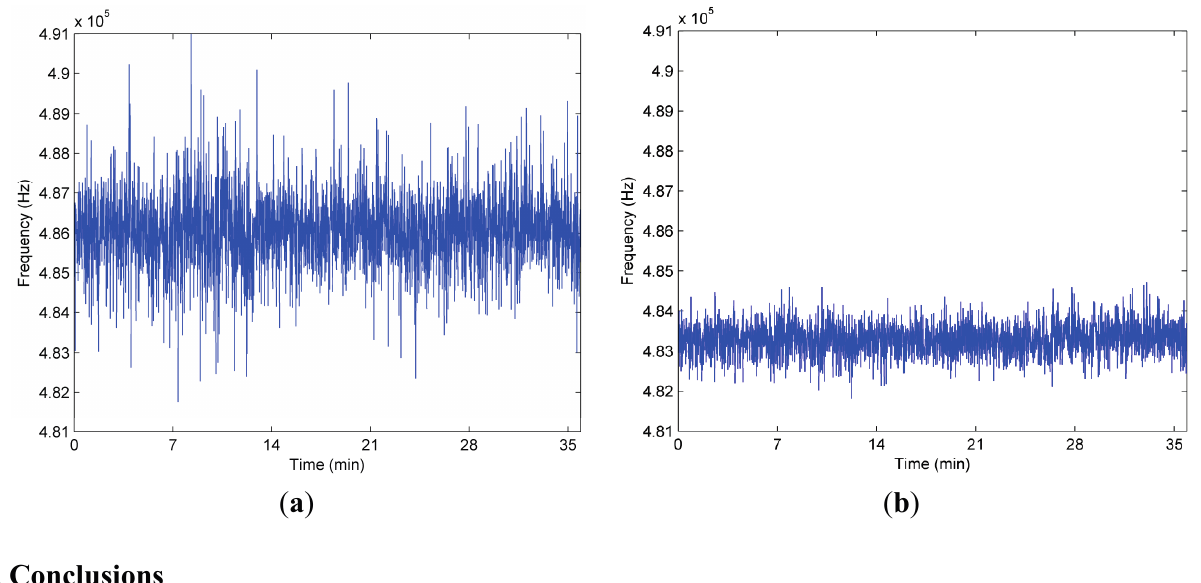
Figure 10. Measured frequency over the measurement time. ( a ) FFT; ( b ) Used